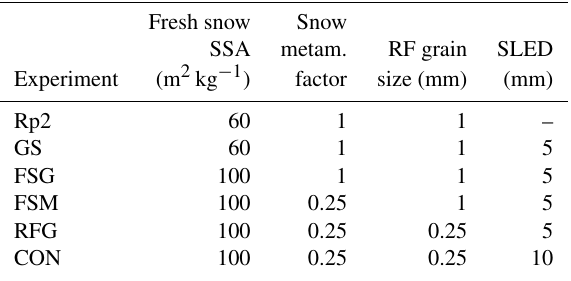
Table 1. Summary of the Rp3 sensitivity experiments. No skin layer equilibration depth (SLED) is defined in Rp2. Fresh snow Snow SSA metam. SLED